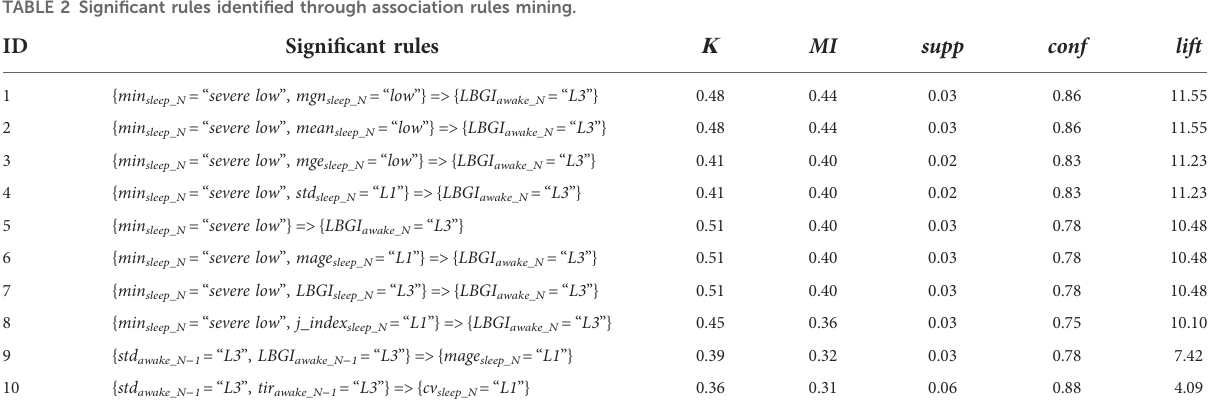
TABLE 2 Signi fi cant rules identi fi ed through association rules mining. ID Signi fi cant rules